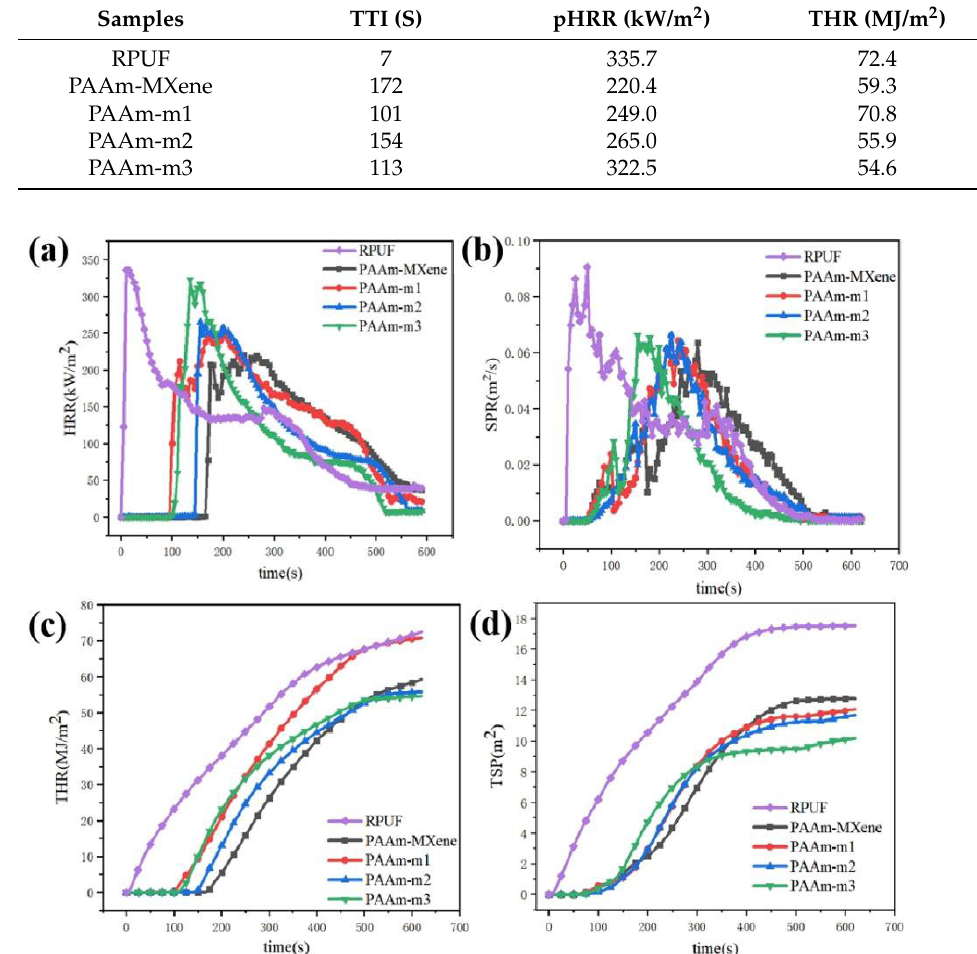
Figure 6. ( a ) HRR curve; ( b ) SPR curve; ( c ) THR curve; ( d ) TSP curve of pure RPUF and Coated RPUF samples.